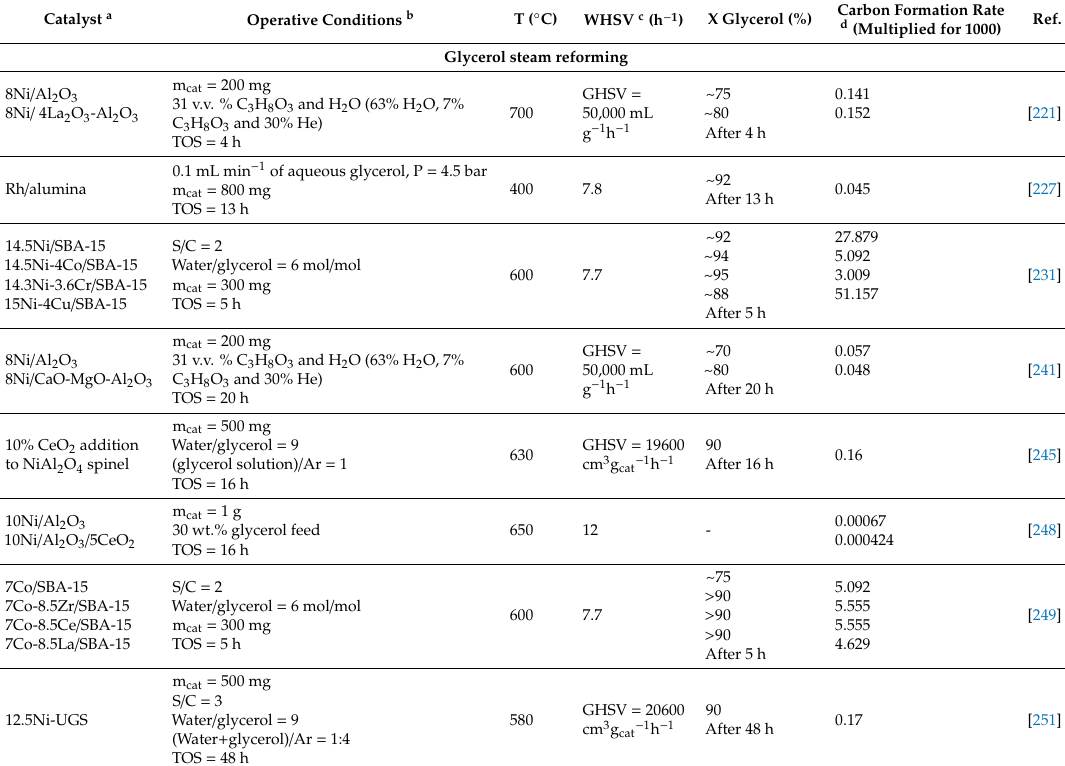
Table 3. Carbon formation rate for various catalysts used for glycerol steam reforming. Catalyst